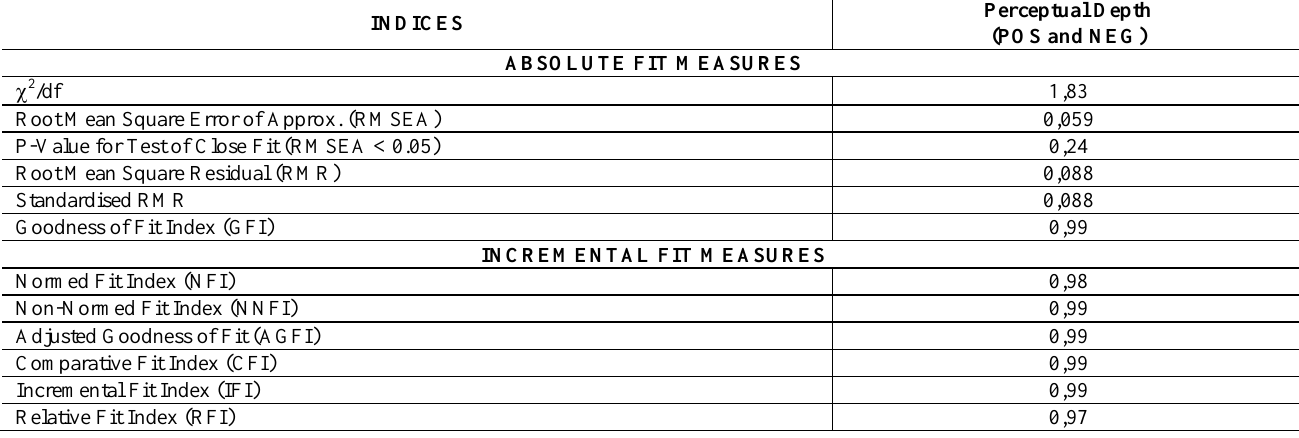
Table 4: Refined measurement scales: factor loadings and